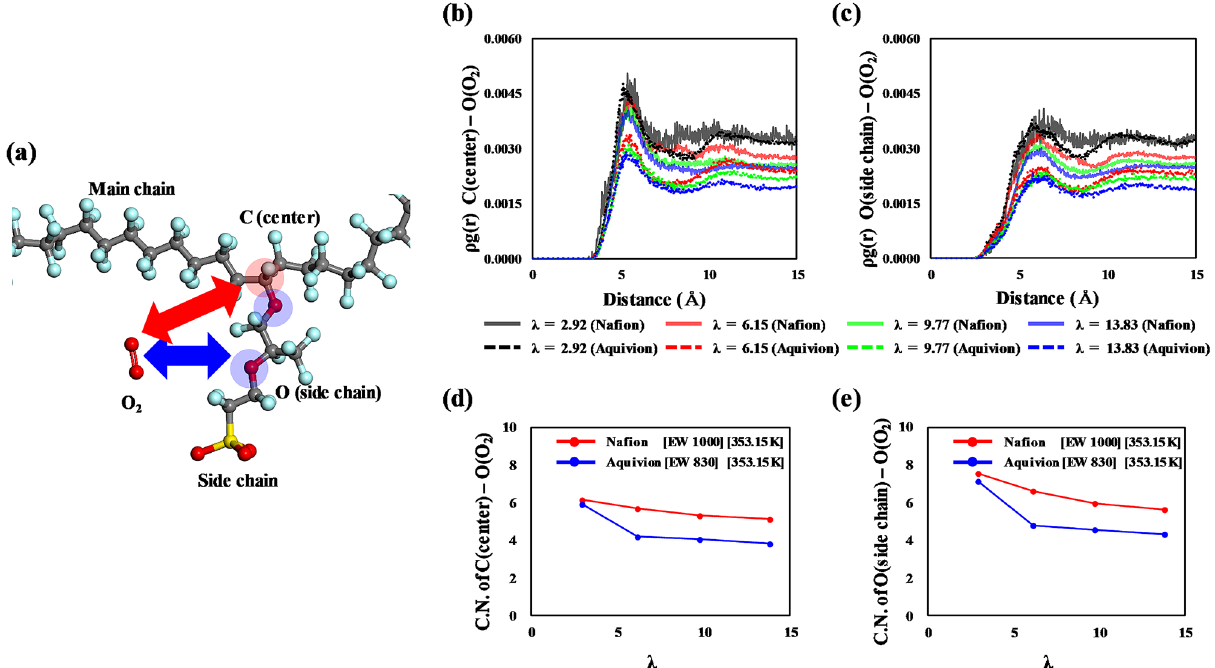
Figure 7. ( a ) Molecular model with the atomic definition for O 2 location analysis using RDFs. RDFs at ( b ) C(center)–O(O 2 ) and c ) O(side chain)–O(O 2 ) and the first coordination number of ( d ) C(center)–O(O 2 ) and ( e ) O(side chain)–O(O 2